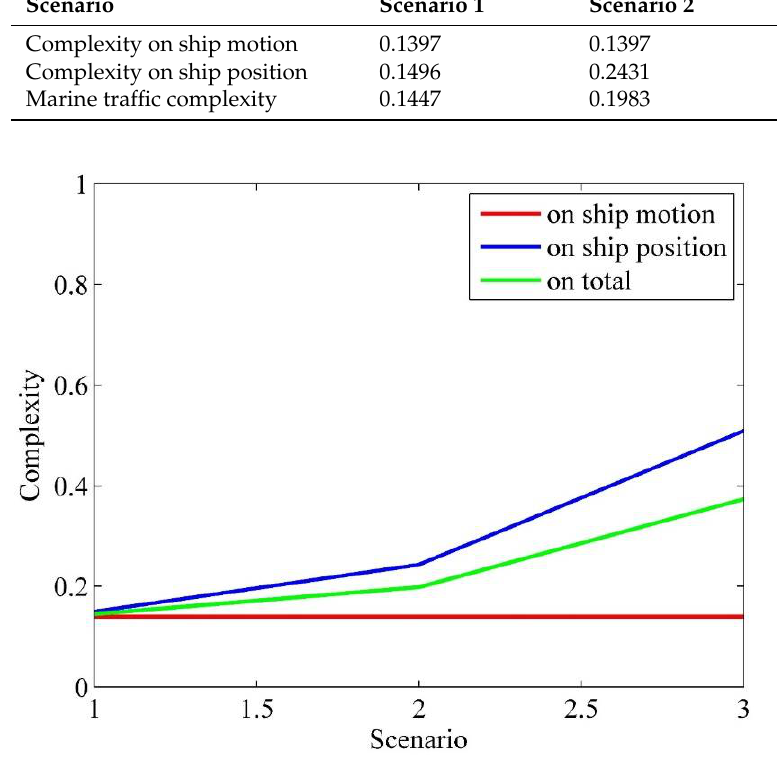
Figure 9. The results of the second simulated case study .